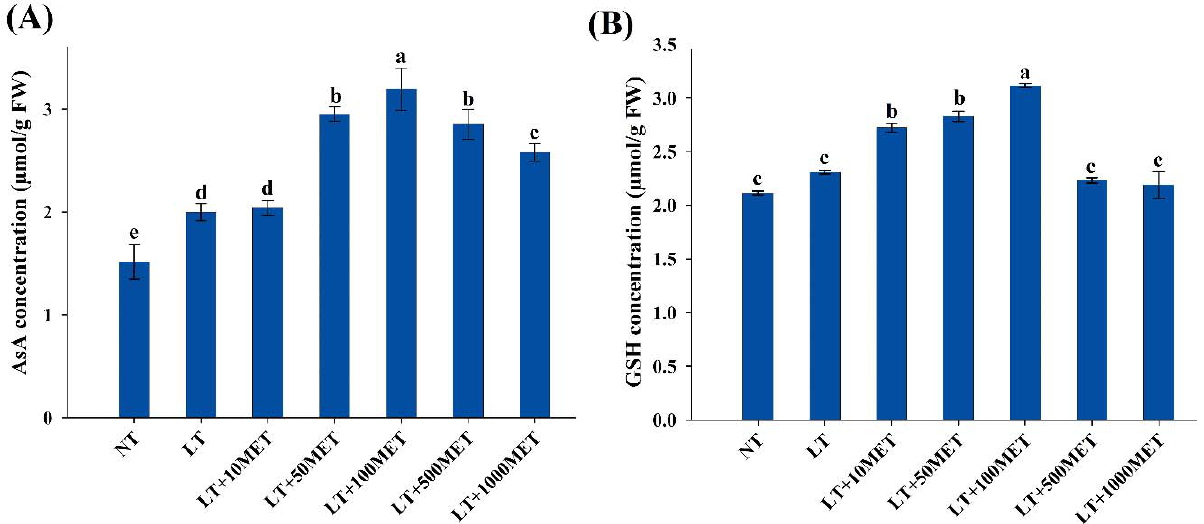
Figure 3. Effects of exogenous melatonin on non-enzymatic antioxidants (AsA ( A ) and GSH ( B )) in strawberry seedlings under cold stress. Plants treated with distilled water under the normal conditions (25 ◦ C) served as control (NT). The strawberry seedlings were pretreated with distilled water (LT), 10 µ M melatonin (LT + 10MET), 50 µ M melatonin (LT + 50MET), 100 µ M melatonin (LT + 100MET), 500 µ M melatonin (LT + 500MET), and 1000 µ M melatonin (LT + 1000MET) 3 times in a two-day interval and then exposed to cold stress for 2 days. Graphs represent the mean of three biological replicates. Values labeled with different letters indicate significant differences among treatments at ( p ≤ 0.05) by